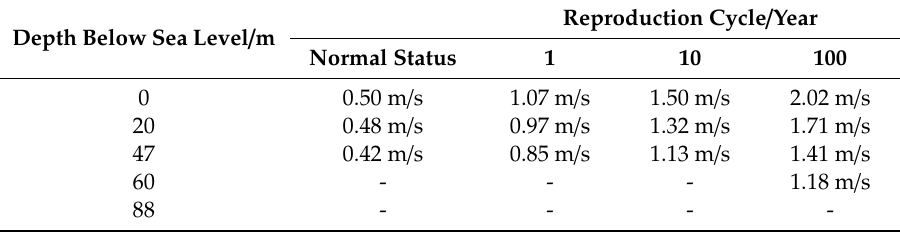
Table 2. Wave parameters.